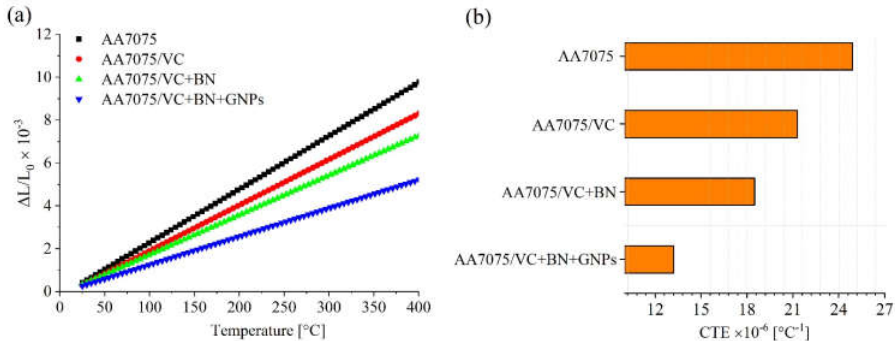
Figure 6. (a) Fractional change in the length (ΔL/L 0 ) and (b) the coefficient of thermal expansion, Figure 6. ( a ) Fractional change in the length ( ∆ L/L 0 ) and ( b ) the coefficient of thermal expansion, CTE, for the base alloy AA7075 and the manufactured composites. CTE, for the base alloy AA7075 and the manufactured